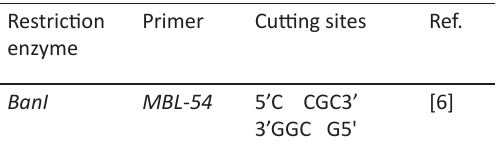
Table 2. Restriction enzyme used in this study Restriction Primer Cutting sites Ref.